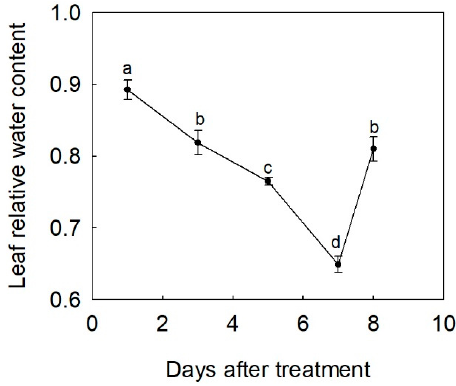
Figure 1. The leaf relative water content of Malus hupehensis plants under drought and rewatering. The plants were watered with saturated water one day in advance, then treated for 7 days without any water, and rewatered on the evening of 7th day. Bars labelled with di ff erent le tt ers indicate signi fi cant di ff erence.